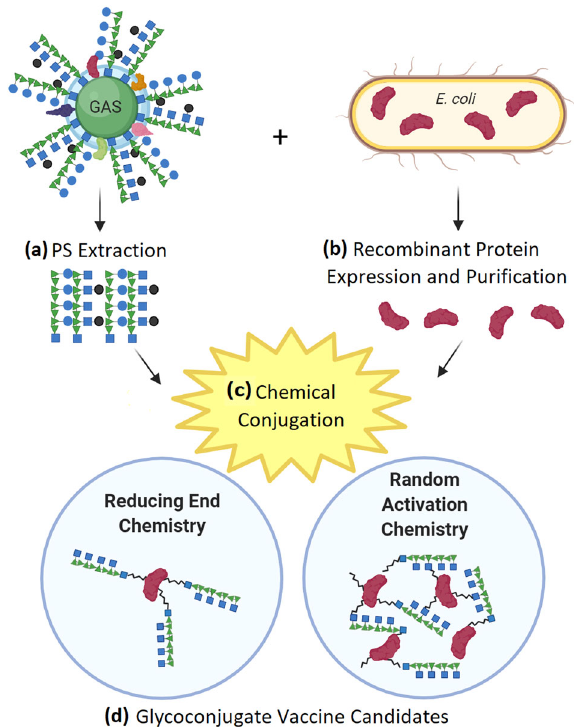
Fig. 2 Simpli fi ed schematic representation of chemical conjuga- tion. Polysaccharide (PS) extracted from the native organism, e.g., GAC from Strep A cells ( a ), and recombinant protein carriers expressed and puri fi ed from E. coli cells ( b ). Extracted PS and recombinant protein carriers containing compatible reactive groups are conjugated together using a compatible cross-linking chemical reagent ( c ) yielding heterogenous glycoconjugate vaccine candi- dates depending on the selected approach ( d ). Schematic shows different approaches yielding different glycoconjugate species, with reducing end chemistries leading to terminal single ended glycoconjugate products (sun-like structures), and random activa- tion chemistries yielding cross-linked mesh-like structures of higher molecular weights with several attached protein - polysaccharide